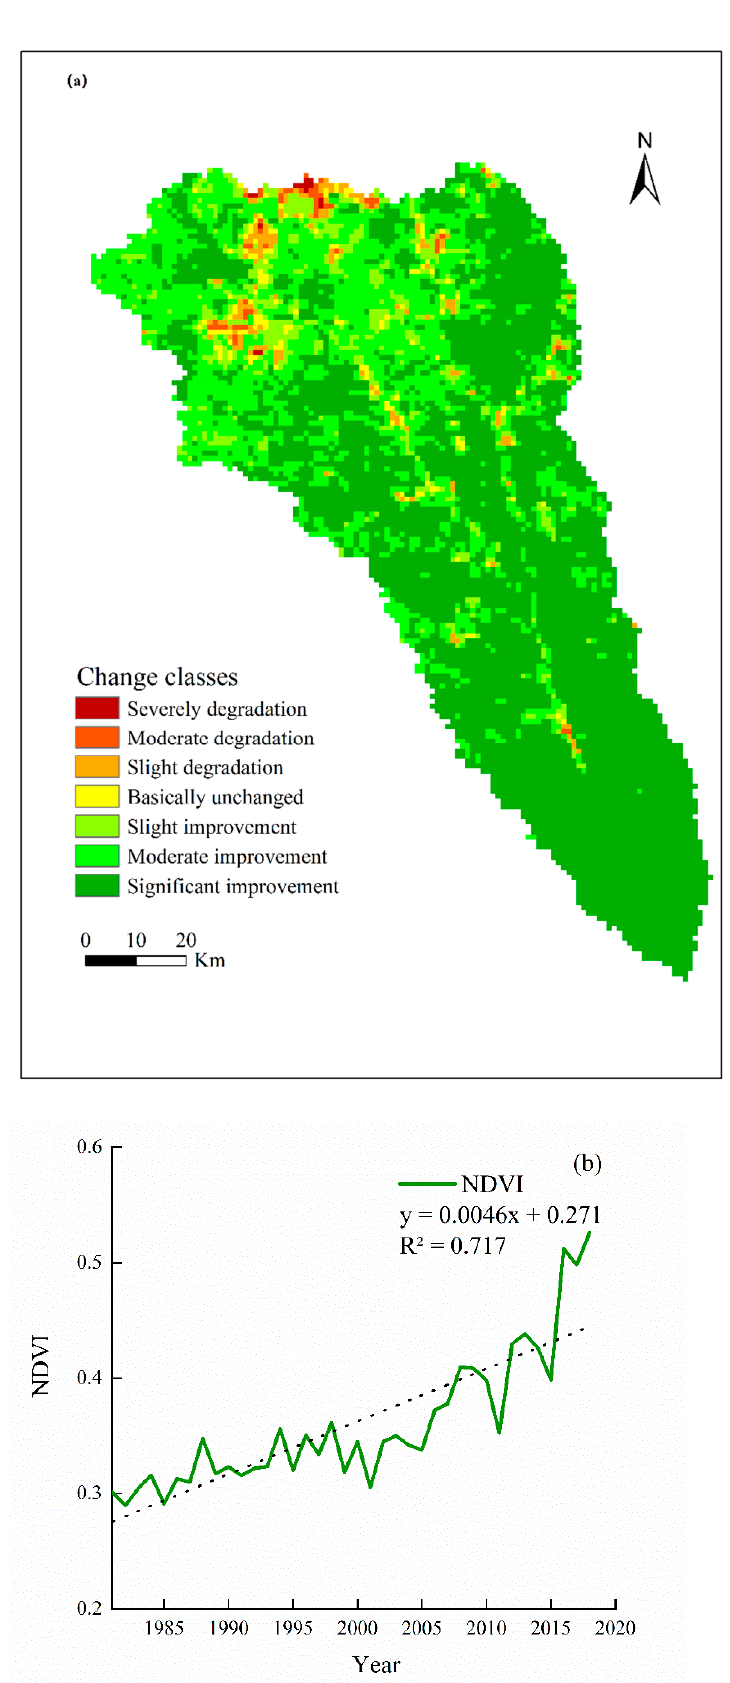
Figure 8. ( a ) Changes in the vegetation cover in the basin between 1980 and 2018 and ( b ) the normalized difference vegetation index (NDVI) trend fit.